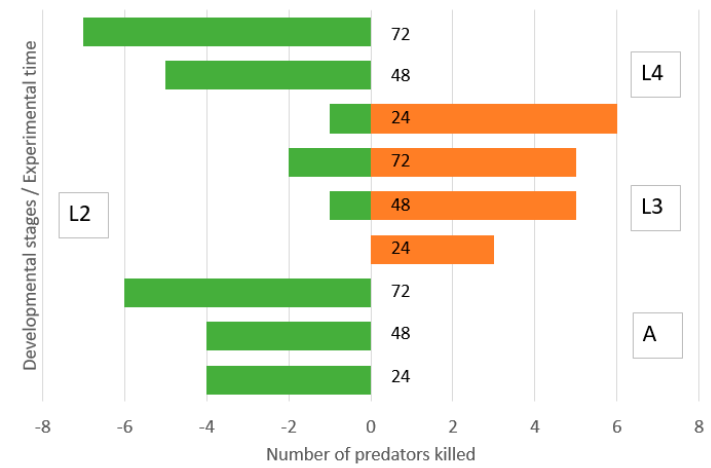
Figure 3. Direction of intraguild predation between Chrysoperla carnea, second instar larvae, and Hippodamia variegata adults (A), third instar larvae (L3) and fourth instar larvae (L4) in the simple arena. Numbers of predators killed of initial N = 40 during 0–24, 24–48 and 48–72 hours.